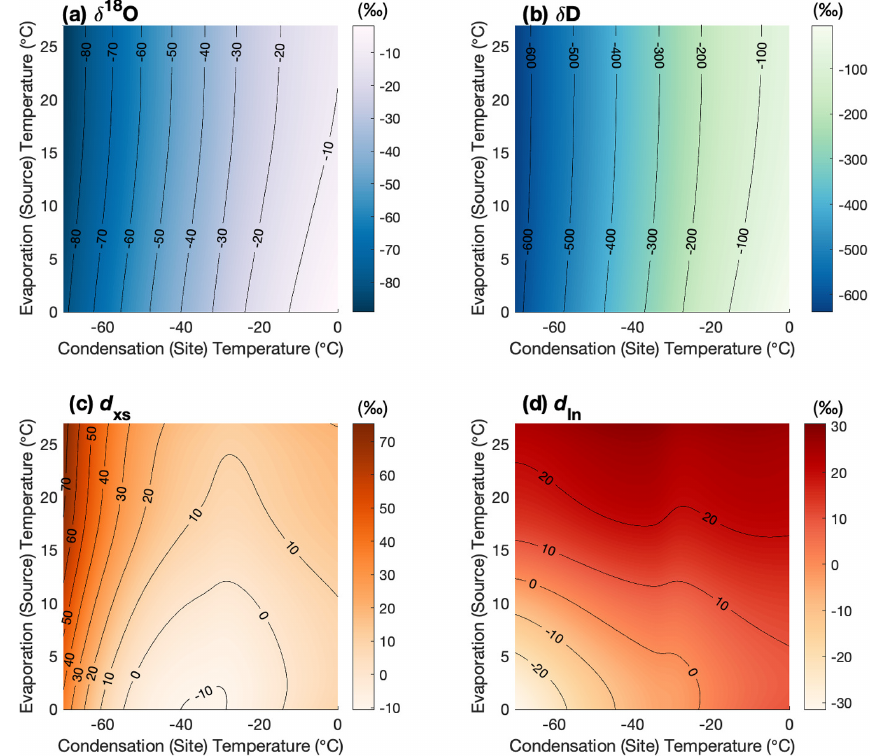
Figure 3. Water-isotope state spaces as a function of the boundary conditions T c , the condensation temperature, and T 0 , the mean evaporation temperature. Surface shading and contour lines are the water-isotope values of precipitation (in units of ‰) (a) δ 18 O, (b) δ D, (c) linear deuterium excess d xs , and (d) nonlinear deuterium excess d ln